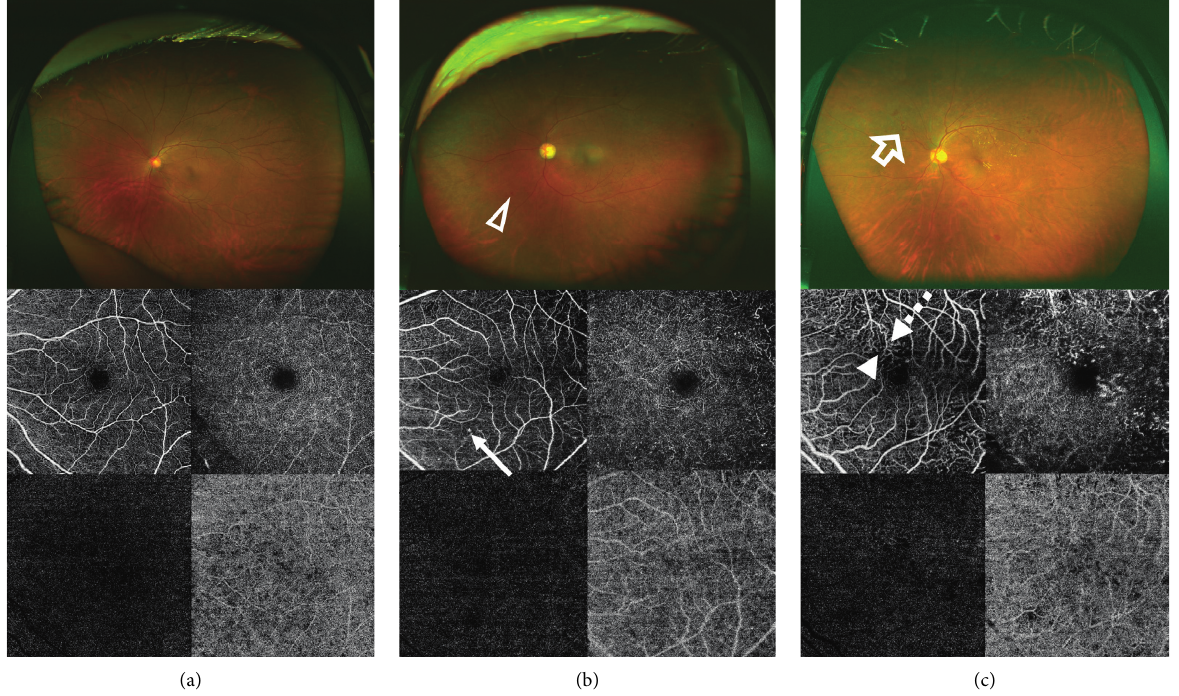
Figure 3: Representative images of no apparent diabetic retinopathy (a), mild nonproliferative diabetic retinopathy (b), and proliferative diabetic retinopathy (c) obtained using ultra-wide-field (UWF) imaging and optical coherence tomography angiography (OCTA). The UWF image shows the hemorrhage (white triangle) and neovascularization (white arrow). The OCTA image shows microaneurysm (white long arrow), microvascular tortuosity (white dotted arrow), and capillary non-perfusion (white short arrow).